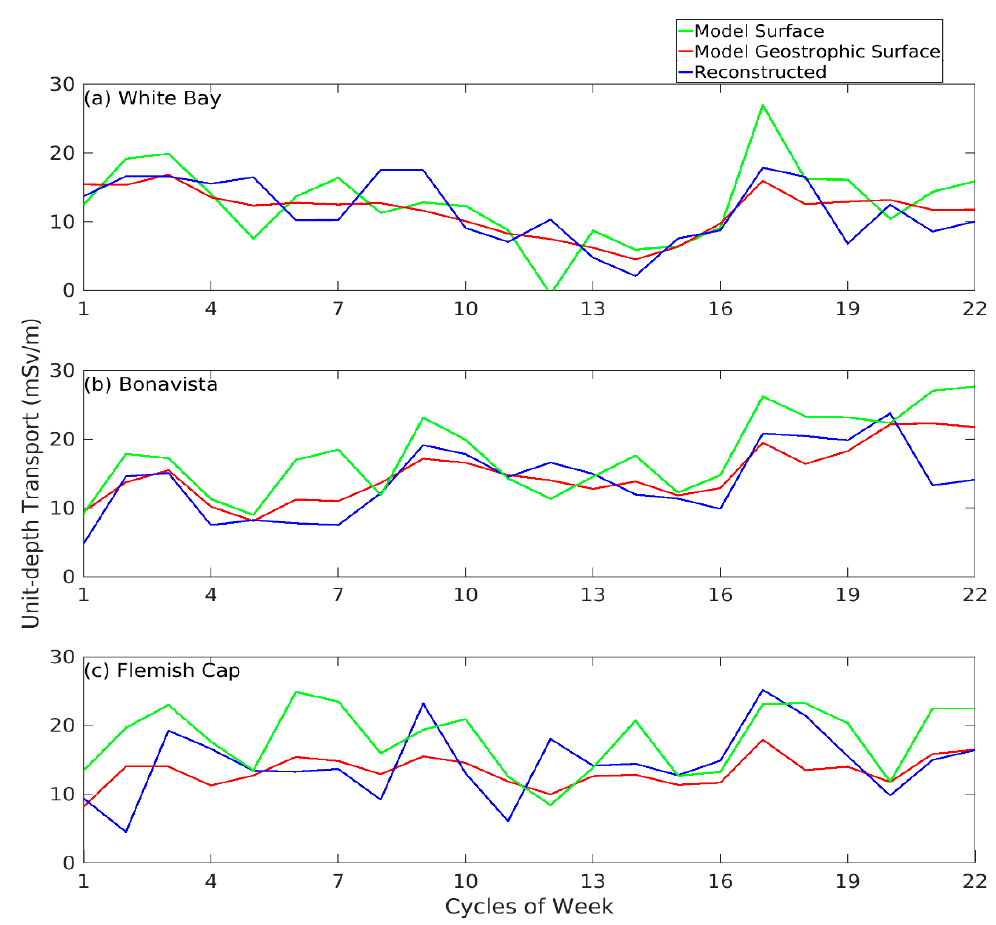
Figure 9. The weekly surface unit-depth Labrador Current transport at the ( a ) White Bay, ( b ) Bonavista, and ( c ) Flemish Cap transects. Table 2. Statistics comparing the reconstructed surface unit-depth transport and the model geostrophic surface unit-depth transport against the model surface unit-depth transport at the White Bay, Bonavista, and Flemish Cap transects. Locations are shown in Figure 1.